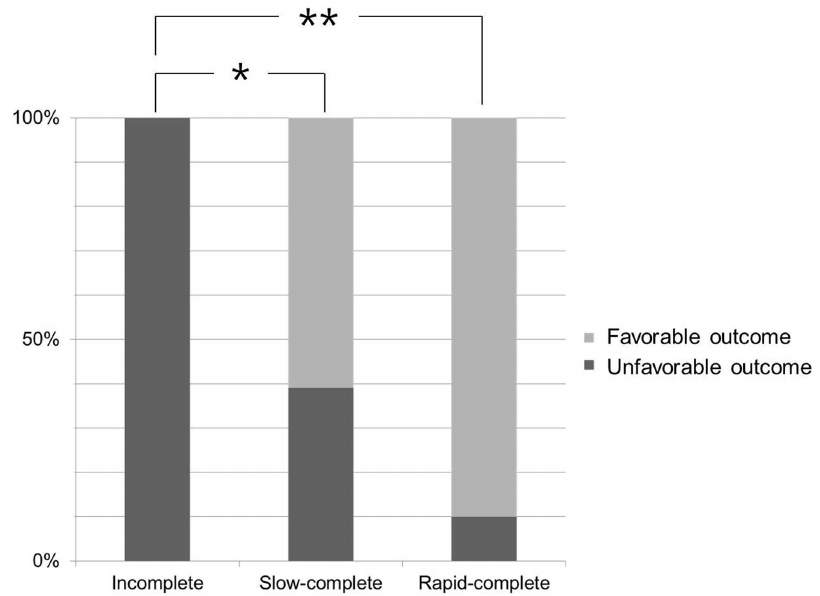
Figure 2. Clinical outcome according to collateral status. All patients with incomplete collaterals showed unfavorable outcome at 3 months. Patients with complete collaterals had favorable clinical outcome more frequently than did patients with incomplete collaterals. * P =0.003; ** P , 0.001